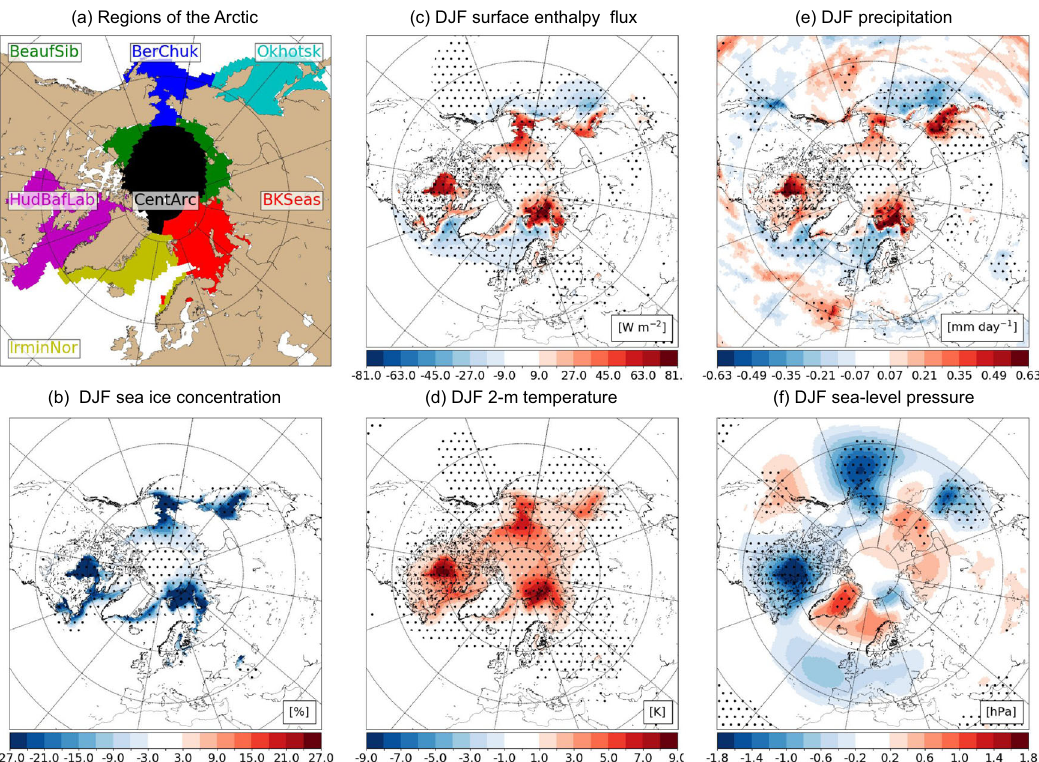
Fig. 1 Surface response to future Arctic sea-ice loss. a Prede fi ned regions over which monthly mean SIC and SST are changed to their late 21st anomalies, as predicted from an ensemble of CMIP5 simulations of a “ business-as-usual ” global warming scenario: Central Arctic (black), Barents – Kara seas (red), Irminger – Nordic seas (yellow), Hudson – Baf fi n Bays and Labrador sea (magenta), Beaufort – East Siberian – Laptev seas (green), Bering – Chukchi seas (blue), and Okhotsk sea (cyan). b Arctic sea-ice concentration (SIC) anomalies for winter (DJF) season in a 21st century, warm climate state ( + 2 °C from preindustrial global-mean surface temperature) derived from an ensemble of RCP8.5 CMIP5 experiments with respect to its observed 1980 – 2014 climatology (see “ Method ” for experimental protocol). c Anomalies in surface enthalpy fl ux, d 2-m temperature, e precipitation, and f sea-level pressure in the pan-Arctic sea-ice loss experiment. Dotted areas indicate regions where the sign of the anomalies agrees in at least 95% of the 1000 bootstrapped